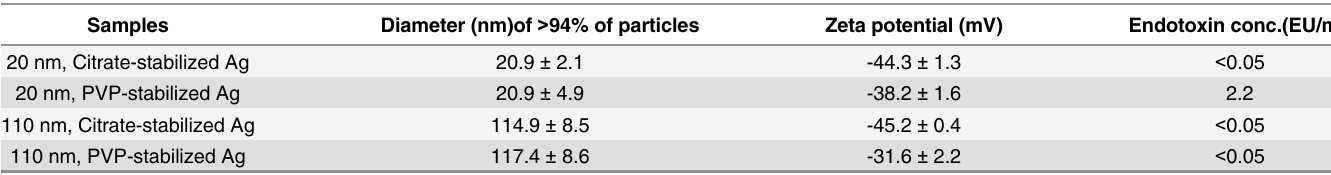
Table 1. Physicochemical properties of AgNP.